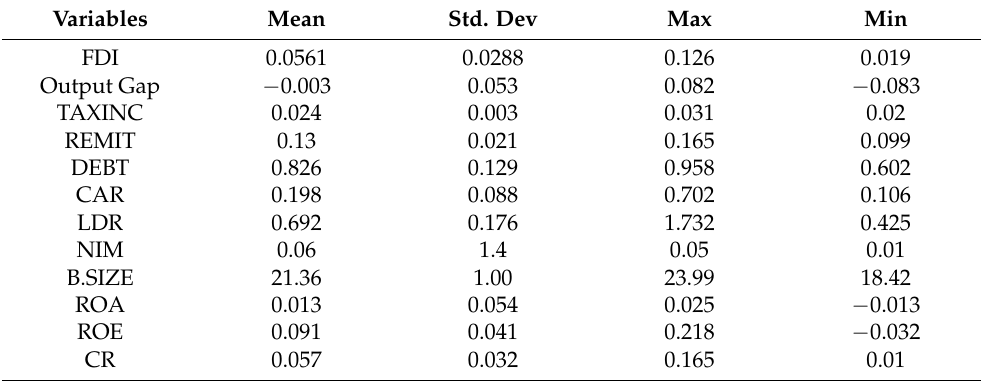
Table 2. Descriptive